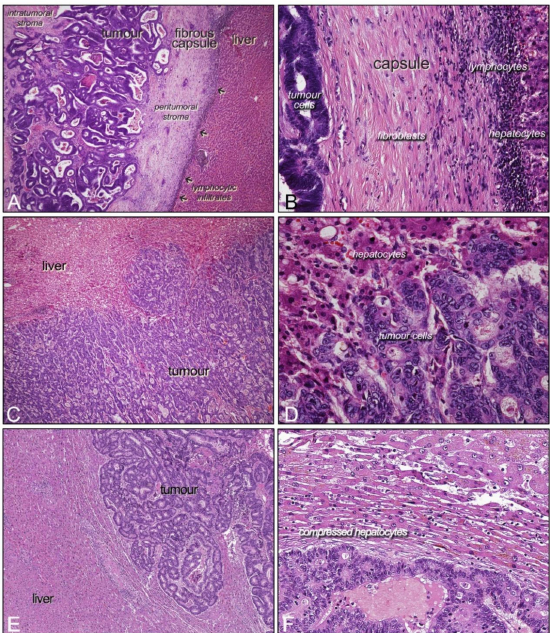
Figure 1. Hematoxylin and eosin staining of histologic growth patterns (HGPs) of liver metastases from colorectal cancer (LM-CRC). ( A , B ) encapsulating/desmoplastic, ( C , D ) invasive/replacement, and ( E , F ) expansive/pushing, the different HGPs at low magnification. In the right column, same patterns at detailed